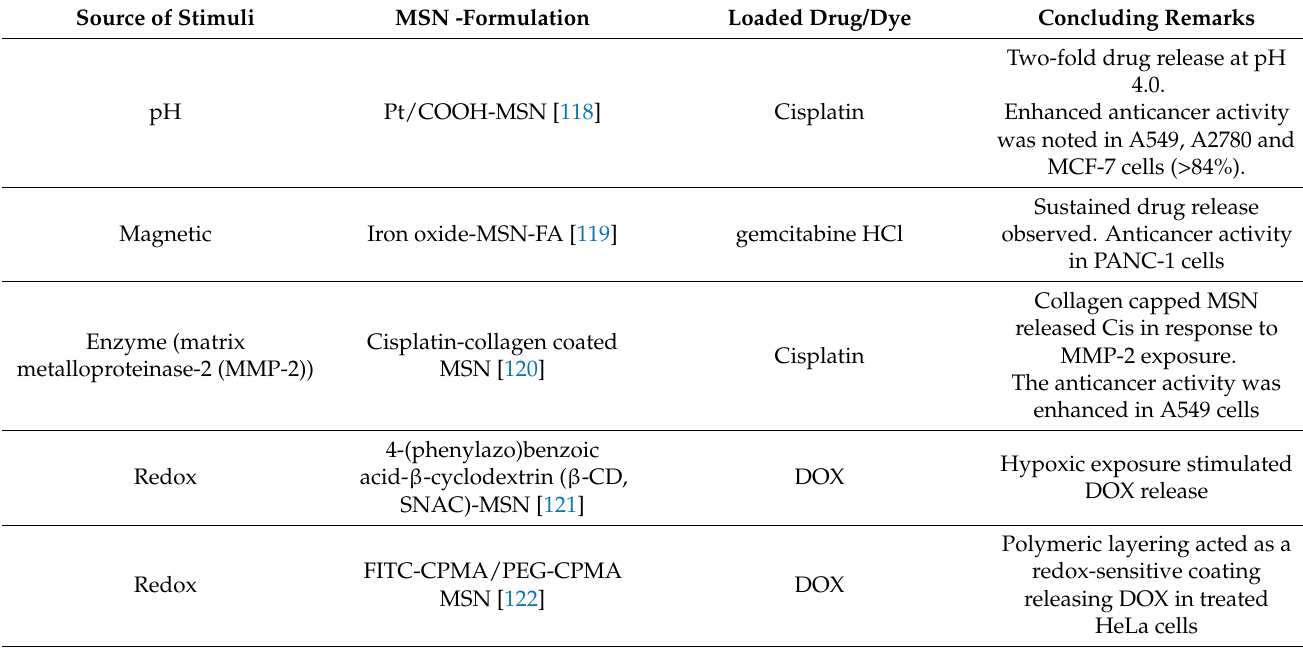
Table 2. Stimuli-responsive MSN systems developed in